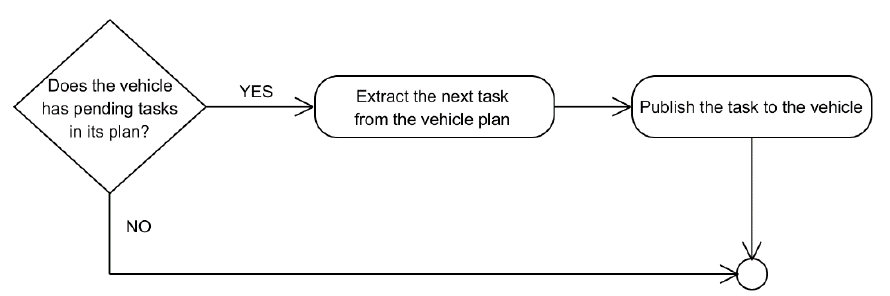
Figure 16. Flow diagram for next task assignment when received a COMPLETED task status.